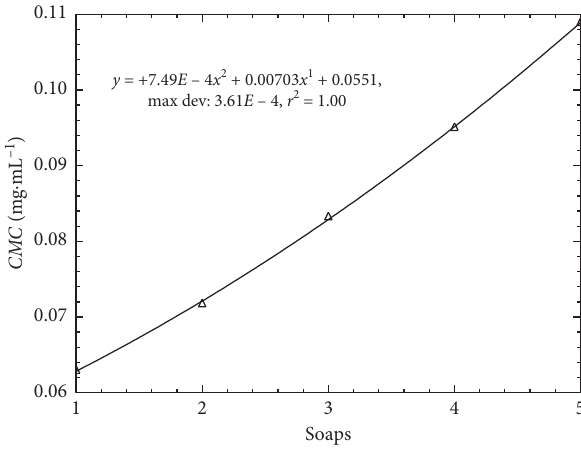
Figure 4: Variation of CMC versus soaps. Figure 2: Variation of ( κ o / κ CMC ) with different soaps: LFBY (1),